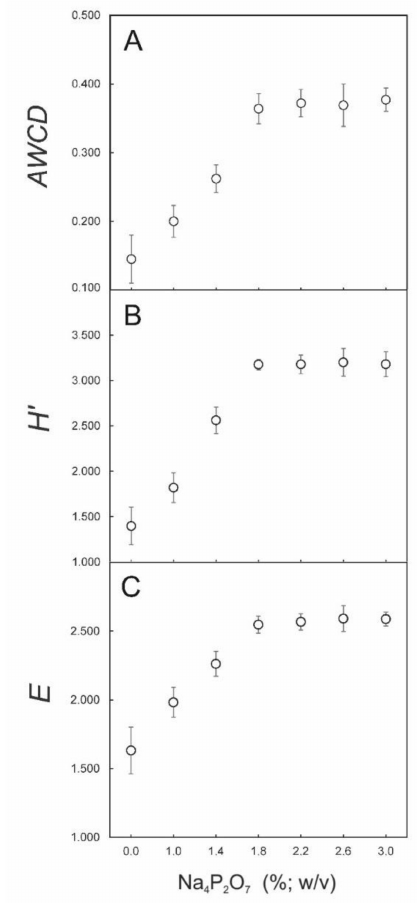
Figure 3. Mean values ( n = 5) ± SD of ( A ) AWCD , ( B ) H’ and ( C ) E measured a 96-h incubation in dilutions (~10 4 CFUs mL − 1 ) of soils from the experimental olive orchard. The dilutions were obtained using di ff erent Na 4 P 2 O 7 • 10 H 2 O